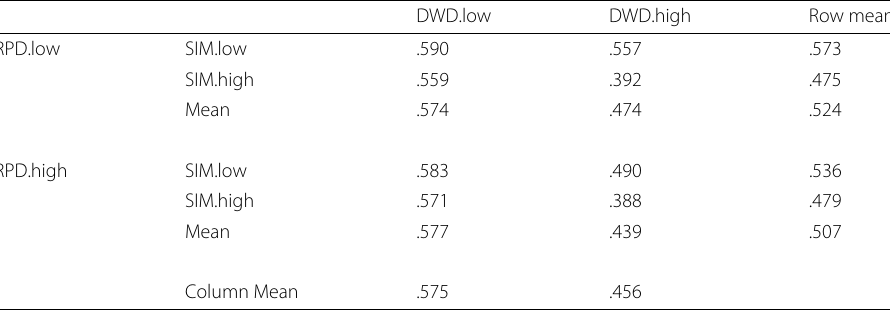
Table 7 Item difficulty means values DWD.low DWD.high Row mean RPD.low SIM.low .590 SIM.high Mean RPD.high SIM.low